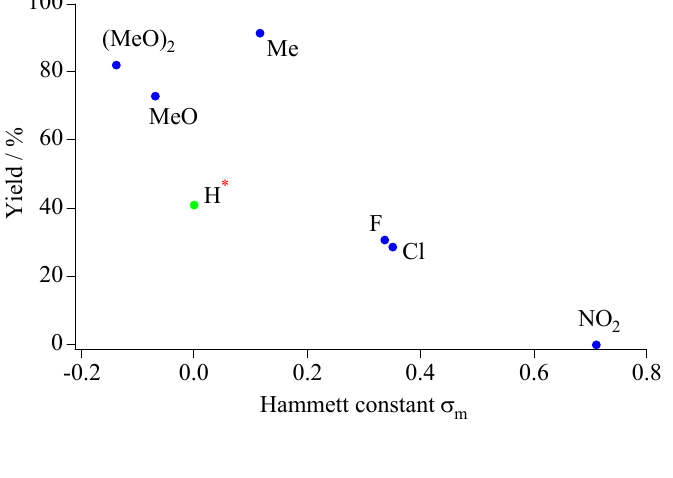
Figure 7. A plot of Hammett constant vs . production yields forbenzo[ b ]furano[60]fullerene